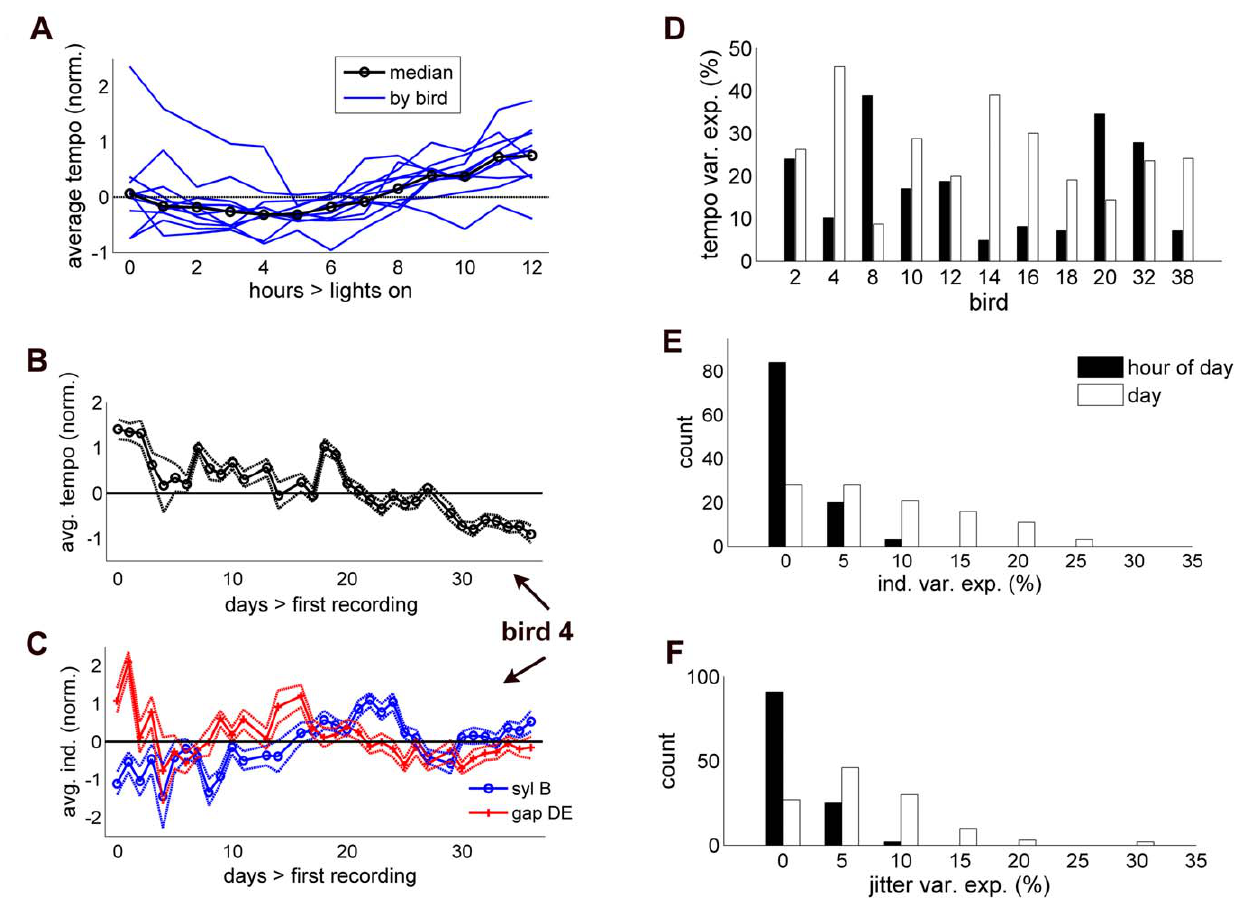
Figure 4. Circadian rhythm and day-to-day drift in the latent timing variables. A, Average tempo by hour of the day (defined from lights on) by bird (blue lines) and averaged across birds (black). B, example of day-to-day drift in tempo for one bird over a 1-month period. C, example of drift in independent variability for two different song segments in the same bird. All data in plots A-C are group means from a two-factor ANOVA that have been adjusted for unequal samples of factor combinations (see Results), while dotted lines in B and C indicate adjusted means 6 standard error. D, The estimated amount of variance in tempo explained by both hour of the day (black) and day (white) across all 11 birds. E and F, histograms of the amount of variance in the independent and jitter variables respectively, explained by both hour of the day and day (same color code). Generally the data show significant circadian variation in tempo only, and day-to-day drift in all three latent timing variables.